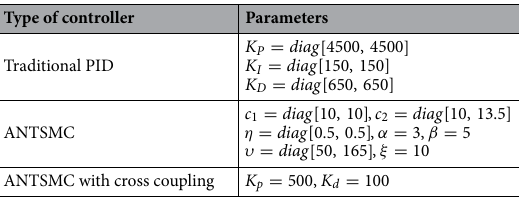
Table 1. Parameters of controller.